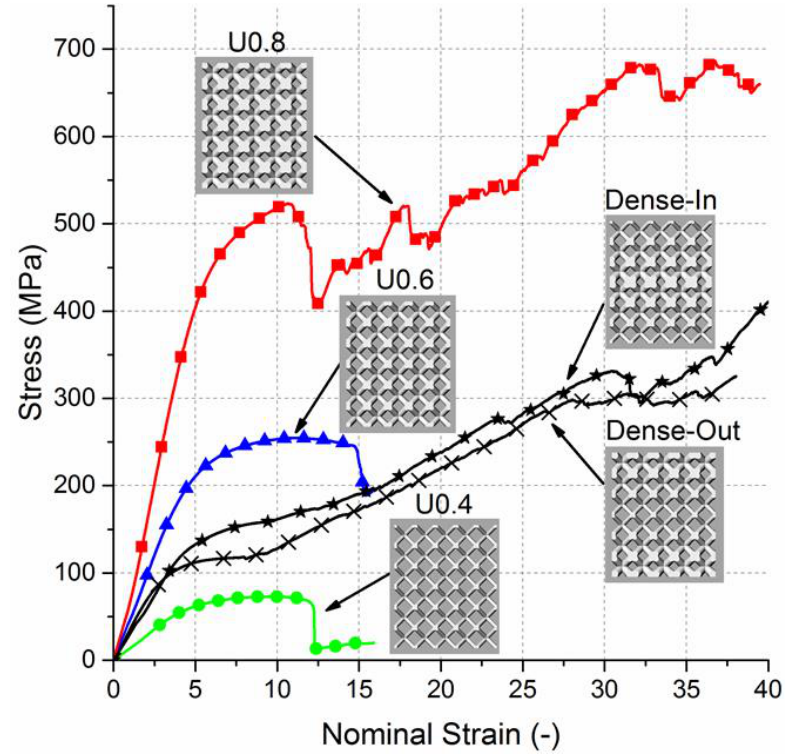
Figure 3. Nominal stress – strain curves for uniform and gradient structures.